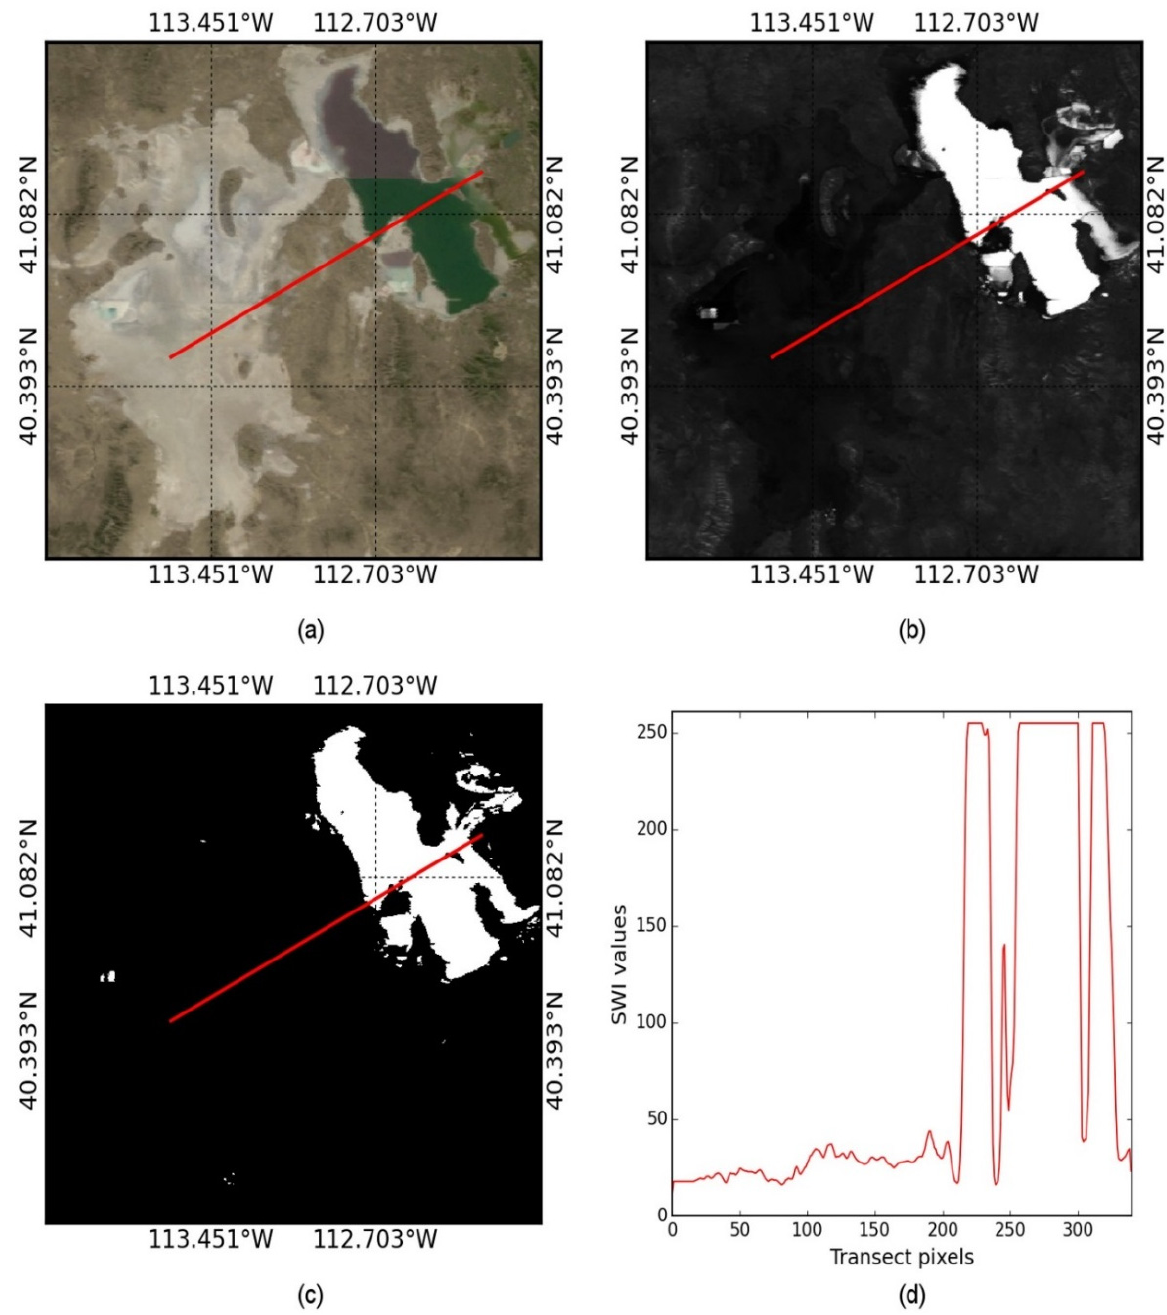
Figure 16. Performance of SWI based extraction of water cover in case of dark soils and high sediments: ( a ) MODIS true-color image, ( b ) SWI image, ( c ) Extracted water cover, ( d ) Profile plot of SWI along the red line